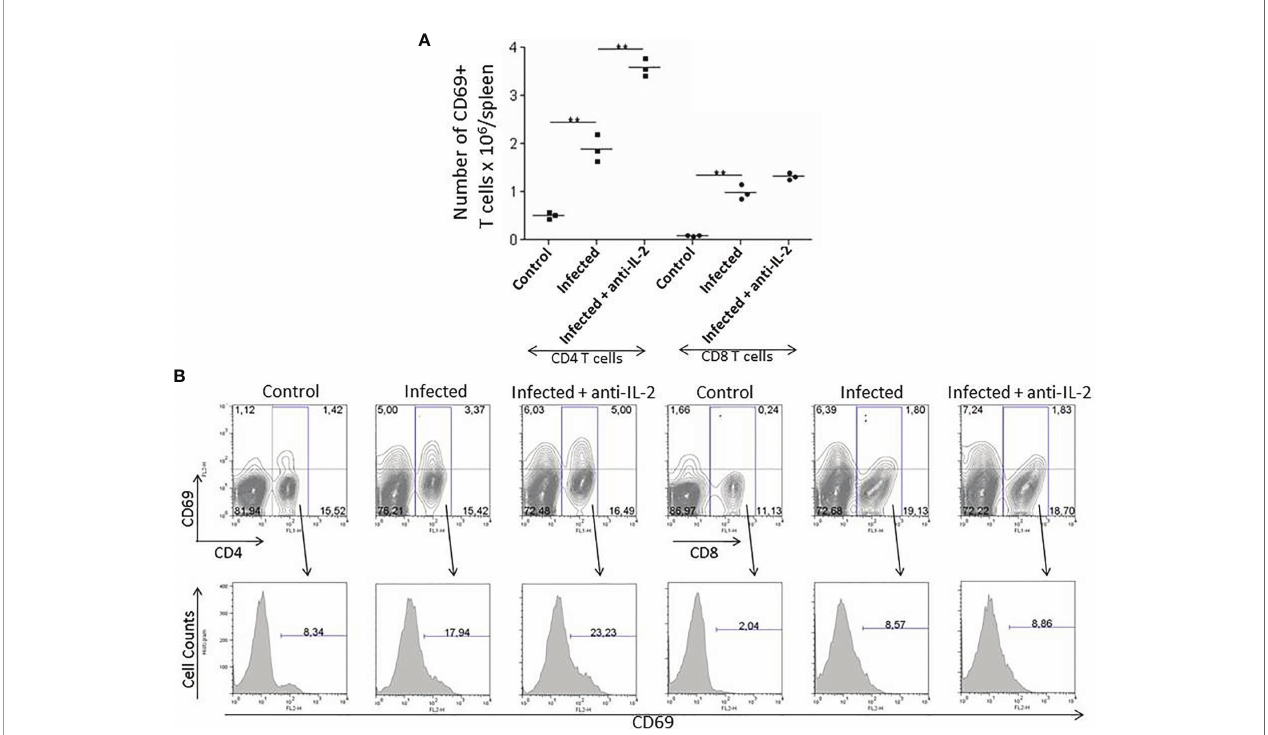
FIGURE 3 | IL-2 blockade leads to increased numbers of early activated splenic CD69 + T cells during the acute phase of T. cruzi infection in C57BL/6 mice. Panel (A) shows the total numbers of splenic early activated CD4+ and CD8+ T cells bearing the CD69 molecule 21 days after infection. Anti-IL-2 treated animals were compared to infected or uninfected control mice treated with rat Ig. Panel (B) shows one representative experiment with FACS plots from 3 pooled spleen cells per group of mice. Histograms represent the expression of CD69 in gated CD4 + or CD8 + splenic T cells. Experiments were repeated on three occasions with similar results (**P < 0.01, n = 3 group, Mann-Whitney